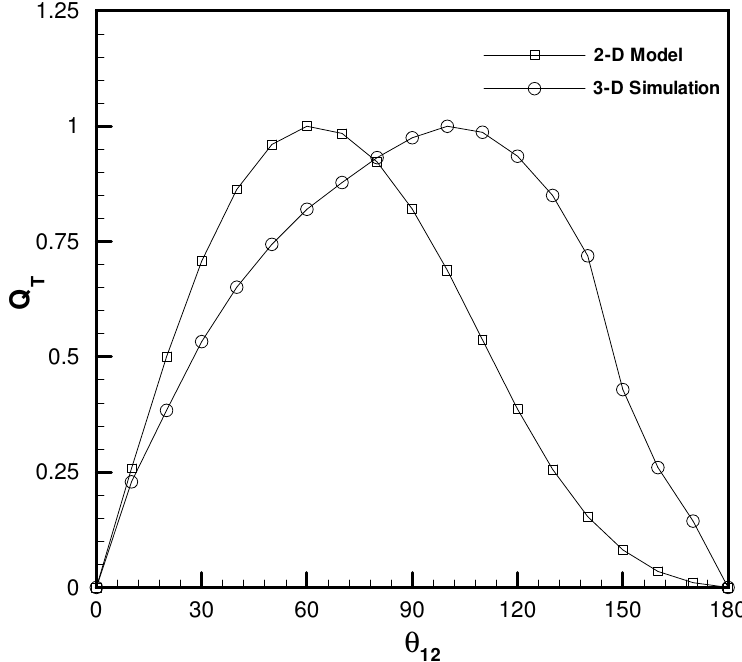
Figure 5. Time-averaged net flow rate comparisons between the 2 D analytical solution and 3 D Stokeslets-mesh-free